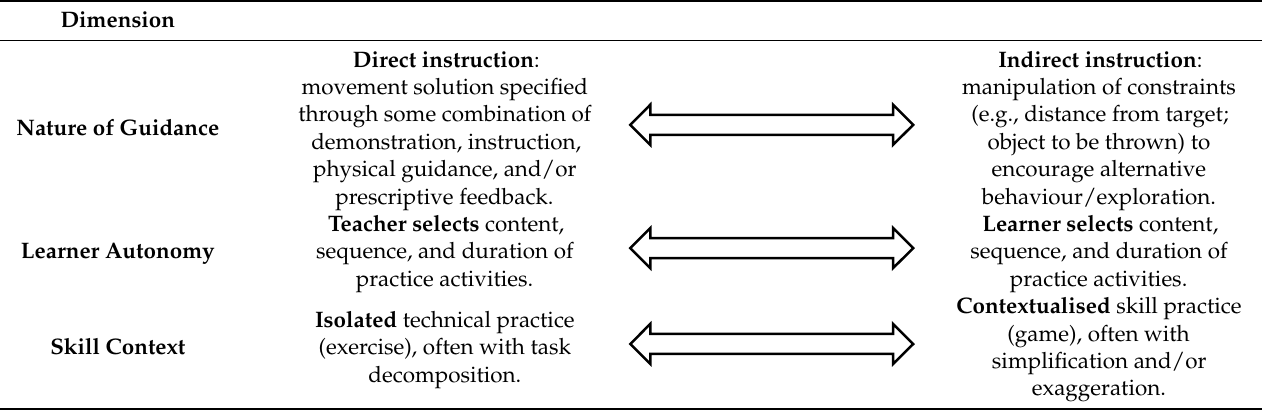
Table 2. Dimensions of practice type to enhance fundamental movement skills.